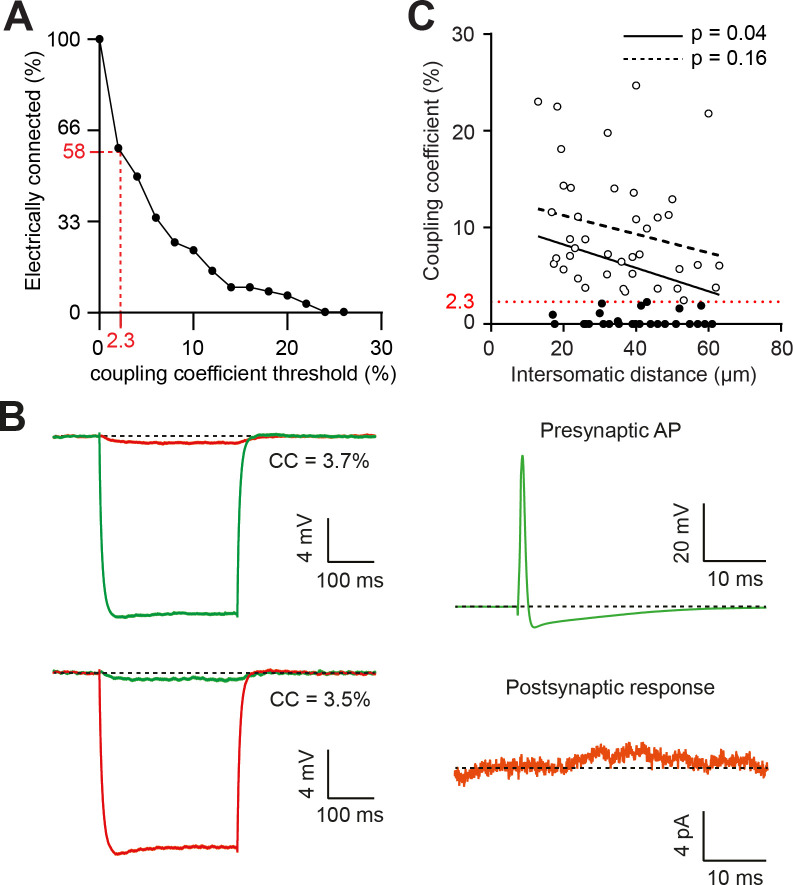
Relationship between coupling coefficients and spikelet transmission, and distance-independence of electrical coupling.(A) Fraction of BC pairs that are considered ‘connected’ according to different coupling coefficient (CC) thresholds. The dotted red lines indicate the observed frequency of detectable spikelet transmission, which corresponds to a CC of 2.3%. (B) Paired recordings of long current pulses injected into one cell (green, top panel; red, bottom panel), with the corresponding hyperpolarization in the second cell of the pair (red, top panel; green, bottom panel). Calculated CCs in either direction give 3.7% and 3.5%, respectively. In this pair, AP firing in the green cell does not cause detectable postsynaptic currents (either inward or outward; traces are averages of 30 sweeps). The presynaptic cell holding potential was −70 mV and the postsynaptic cell holding potential was −60 mV. This may result from electrical coupling via a third MLI. (C) CC versus intersomatic distance between simultaneously patched BCs. Linear regression analysis reveals that for strongly coupled BC-BC pairs (CC >2.3%, white dots) CCs do not significantly decrease with intersomatic distance (within 70 µm; p=0.16, dotted line). However, if all pairs are considered (black and white dots), CCs do significantly decrease with intersomatic distance (p=0.04, black line). See also Figure 4—figure supplement 1—source data 1.